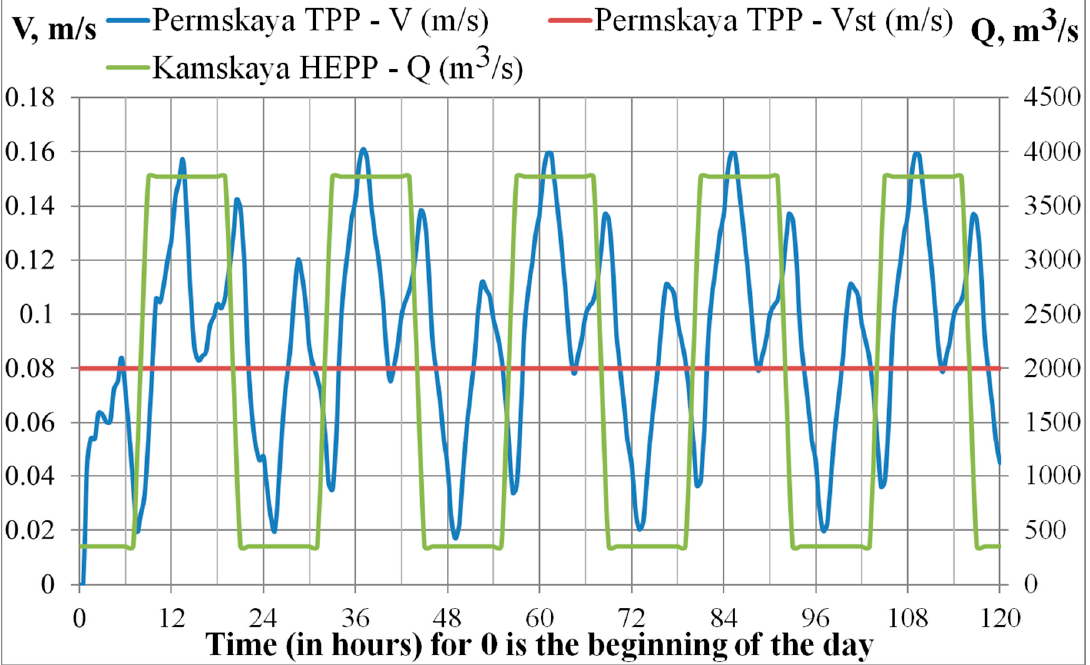
Figure 7. Change in the velocity module in the area of the water intake channel of Permskaya TPP (blue line), in comparison with the change in discharge flow rate of water from the Kamskaya HEPP (green line) and in comparison with the velocity module at a constant discharge of water through the Kamskaya HEPP (red line).